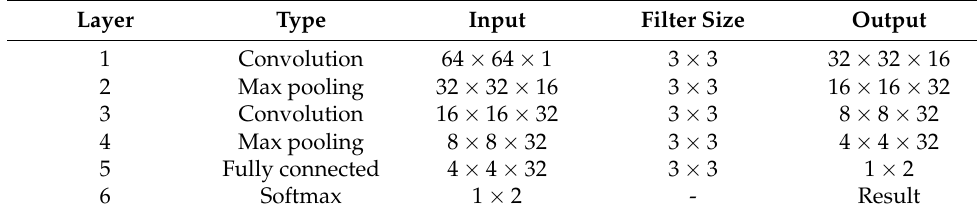
Table 1. WMNet parameters.